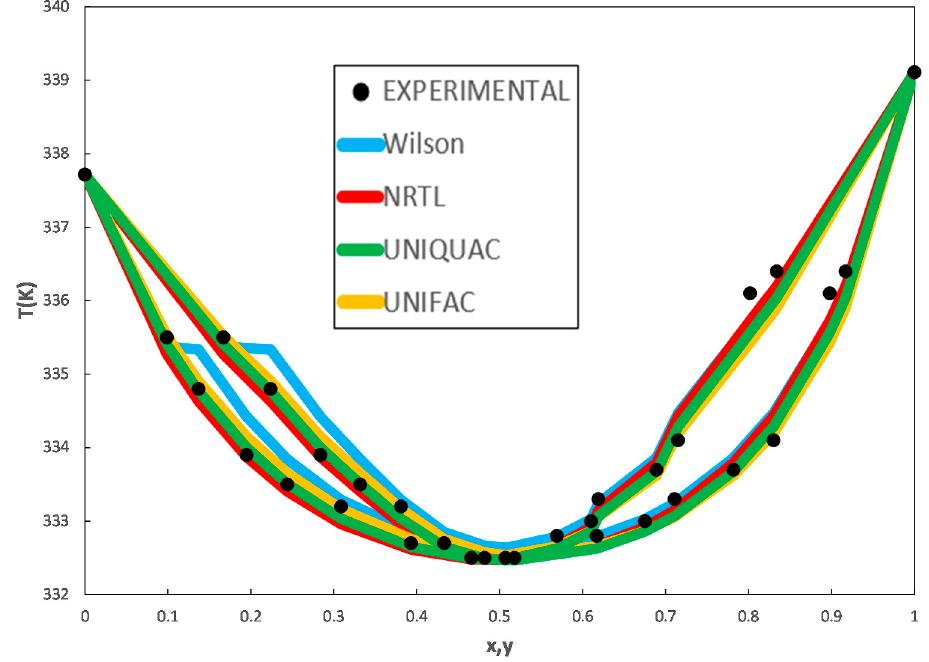
Figure 3. Experimental [14] and predicted T-xy diagram of THF(1) + Methanol(2) at 103 kPa using Wilson, NRTL, UNIFAC, and UNIQUAC as predictive models.